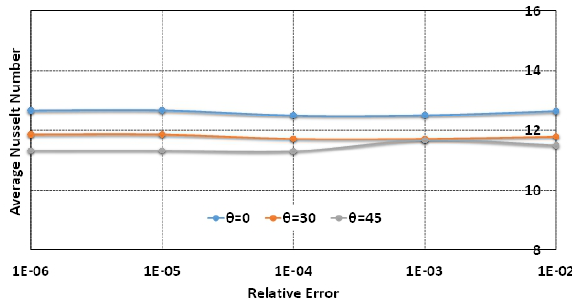
parity of the average Nu for the hot surface with the rela- tive error. It can be realized that when the inclination angle θ = 0 ◦ and θ = 30 ◦ , the values of average Nu are approxi- mately the same when the relative error is set at 10 − 3 and 10 − 4 . The accuracy of 10 − 3 was chosen as a compromise for the results accuracy. For θ = 45 ◦ , the values of average Nu are the same when the relative error is set at 10 − 5 and 10 − 6 and accuracy of 10 − 5 was chosen for these results. As for the maximum time takes place to execute the program in most cases, it is approximately 195 seconds.